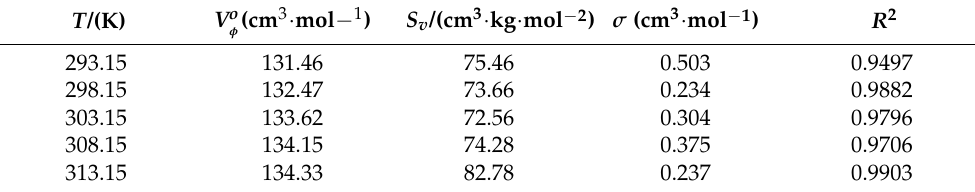
Figure 4. The dependence of the apparent molar volume ( V φ ) on caffeine molality ( m ) in caffeine in 0.1 mol ∙ kg − 1 SS aqueous solutions at different temperatures ( T ) = ( ) 293.15, ( ▲ ) 298.15, ( ) 303.15, ( ) 308.15, and ( ◆ ) 313.15 K. Table 3. Fitting parameters obtained using the Masson ′ s equation modified for non-electrolytes of caffeine in SS aqueous solutions in the temperature range from T = 293.15 to 313.15 K, with the standard deviations ( σ ) and regression coefficients ( R 2 ).